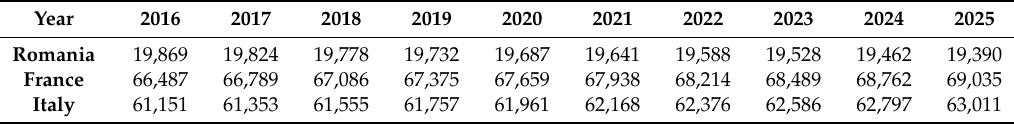
Table 1. The population variation in a forecast period (million residents). Source: